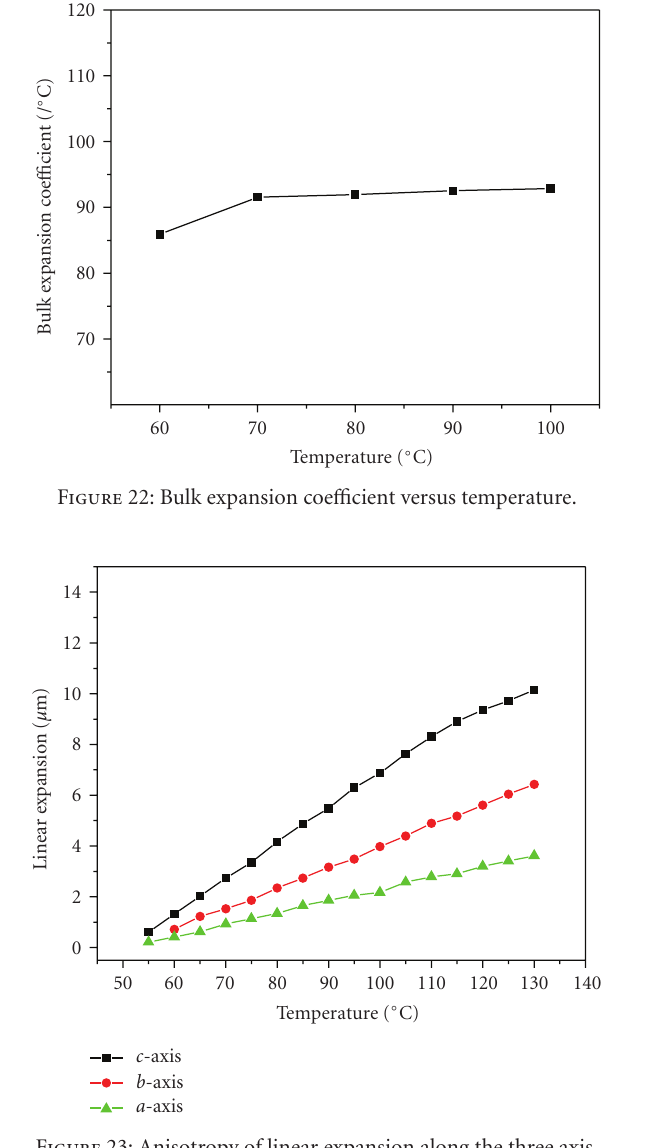
Figure 23: Anisotropy of linear expansion along the three axis.